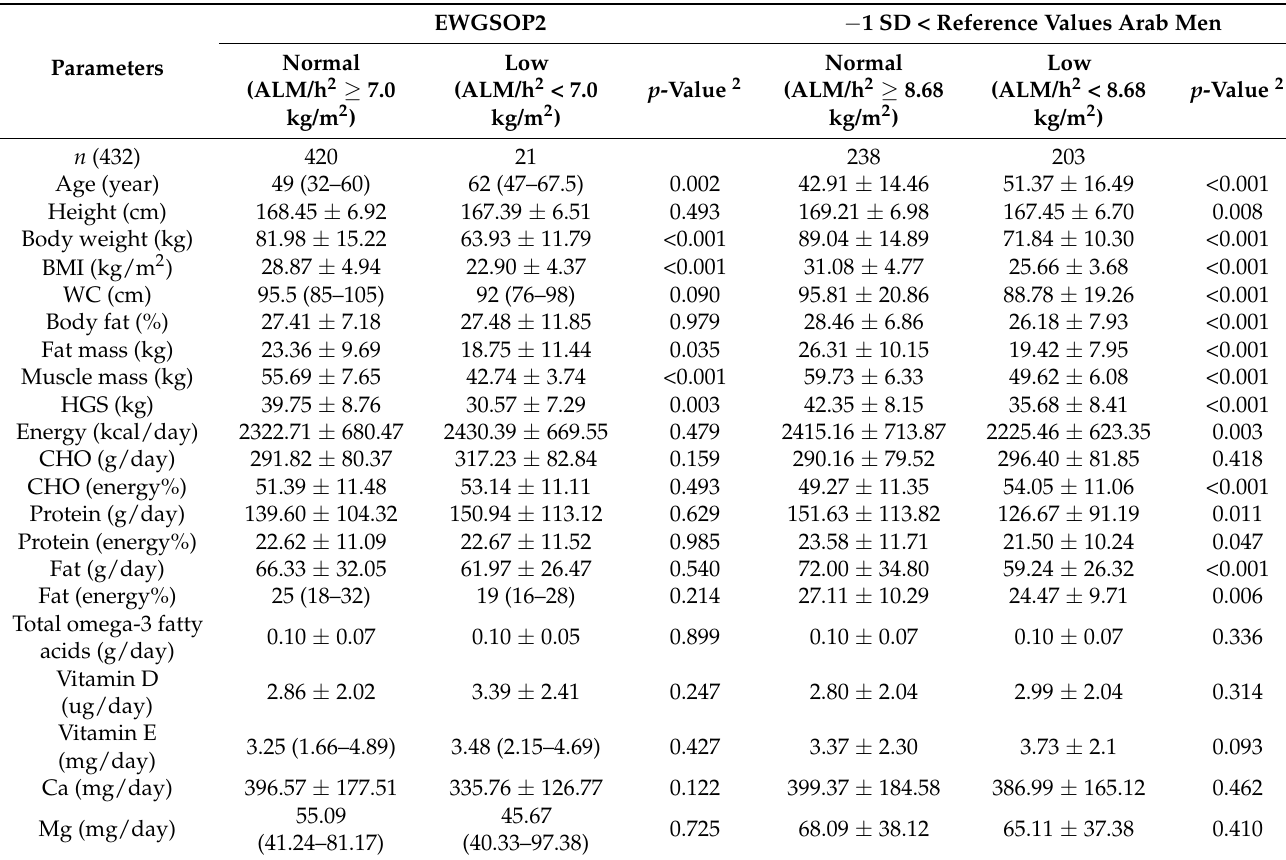
Table 2. General characteristics and nutrient intake of study participants based on different ALM/h 2 reference values 1 .